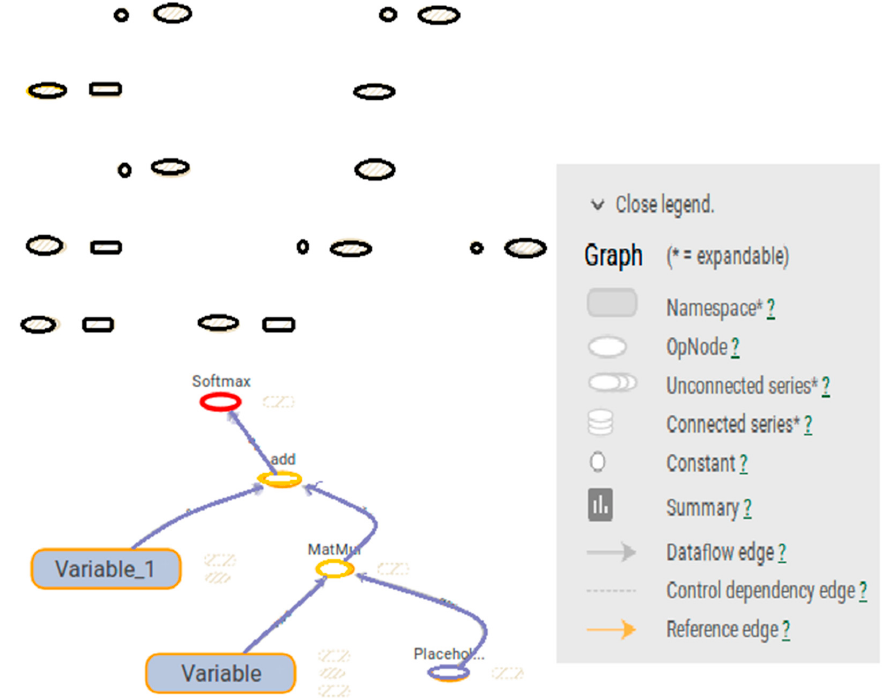
Figure 2. Visualized graph of the calculation graph in TensorBoard.